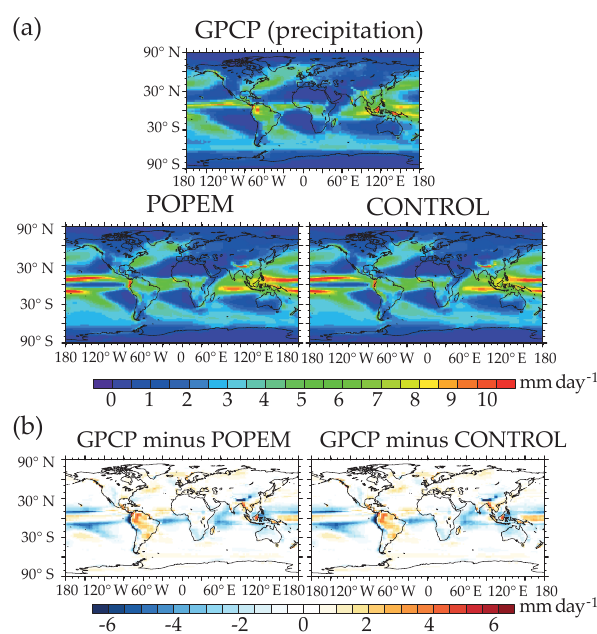
Figure 7. A comparison of the global annual mean precipita- tion (1980–2000) as simulated by the CESM (POPEM and CON- TROL) model and GPCP observational database. (a) Global an- nual mean precipitation maps for GPCP, POPEM, and CONTROL. (b) Absolute difference maps. Units are in mmday − 1 .